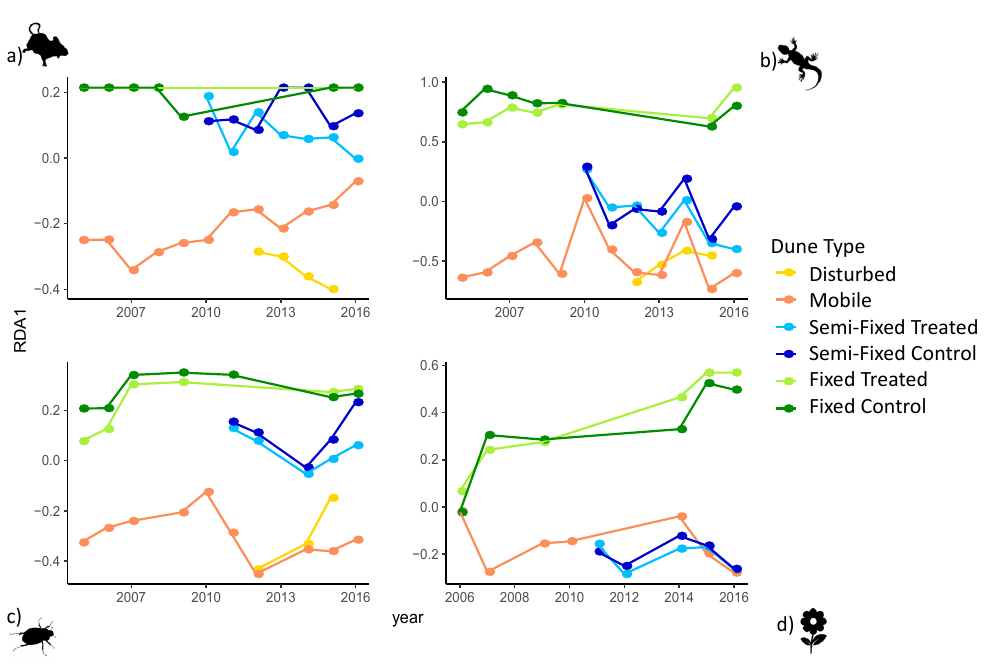
Figure 9. Temporal Redundancy Analysis (RDA) curves ( a ) rodents, ( b ) reptiles, ( c ) beetles and ( d ) annual plants, for all dune types together showing relative contribution to the first axis from 2006–2016, with year as a covariable. Data points are the scores for centroids of each dune type in a given year.